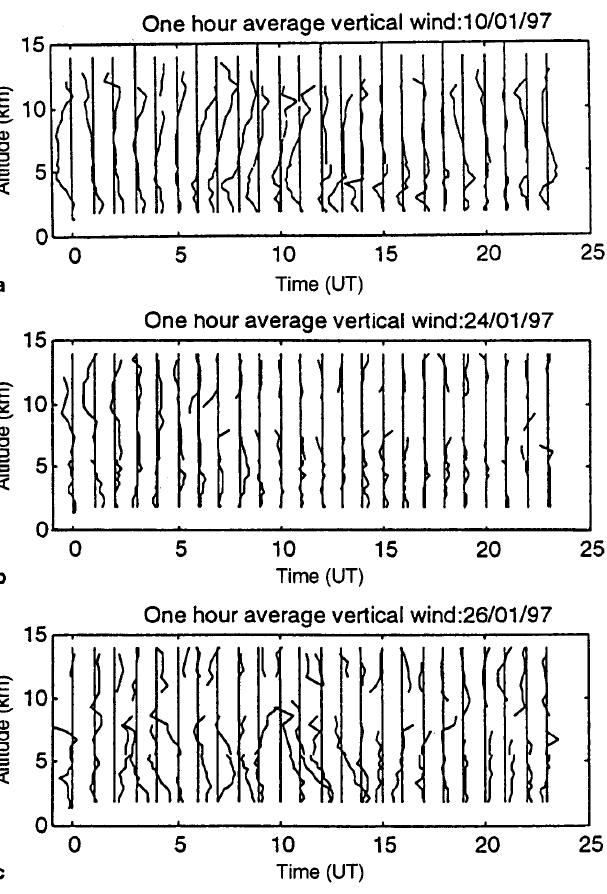
Fig. 8. Profiles of hourly vertical wind averages for 10 January 1997 ( a ), for 24 January 1997 ( b ) and for 26 January 1997 ( c ). The distance between the profiles corresponds to 1 m/s